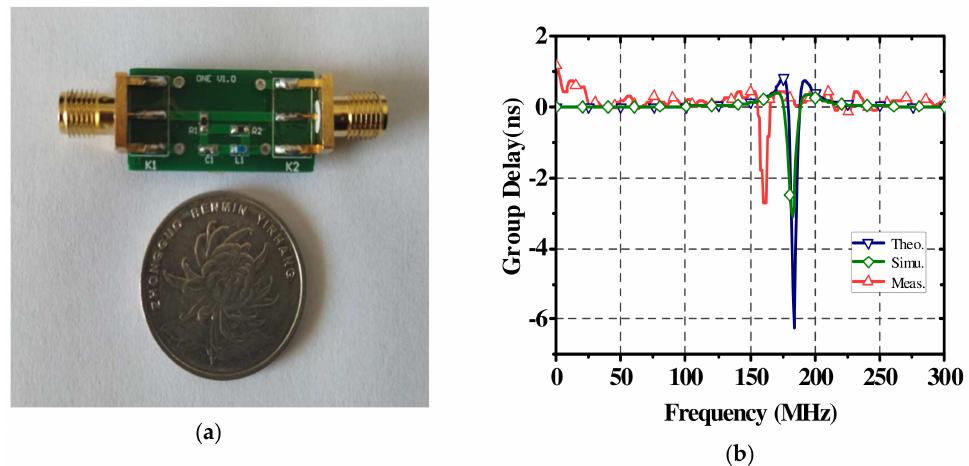
Figure 7. Band-pass NGD circuit ( a ) the fabricated band-pass NGD circuit; ( b ) negative group delay of band-pass NGD circuit.